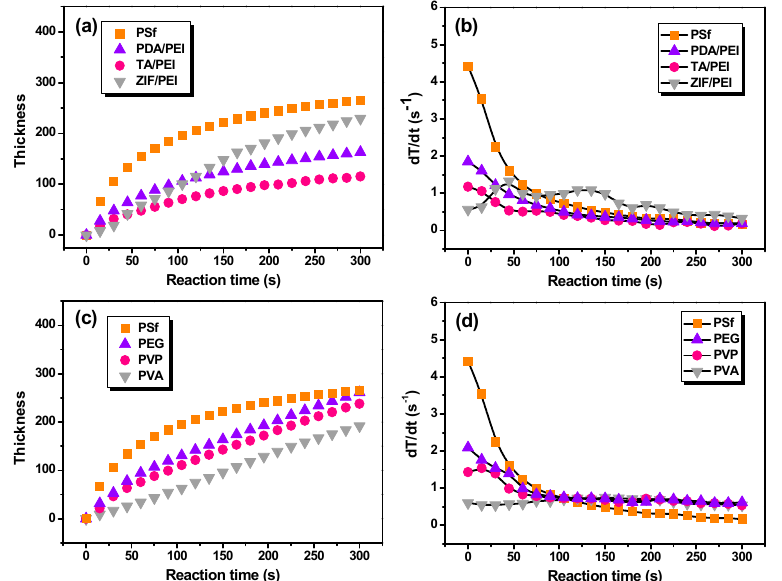
Figure 3. The growth of calculated polyamide layer thickness and the correspondingly polyamide layer thickness growth rate, as a function of IP reaction time including ( a , b ) IP reaction taking place on the porous substrates with various modified interlayers, ( c , d ) the doped polyamide layer with the macromolecular additives in the aqueous solution of PIP.